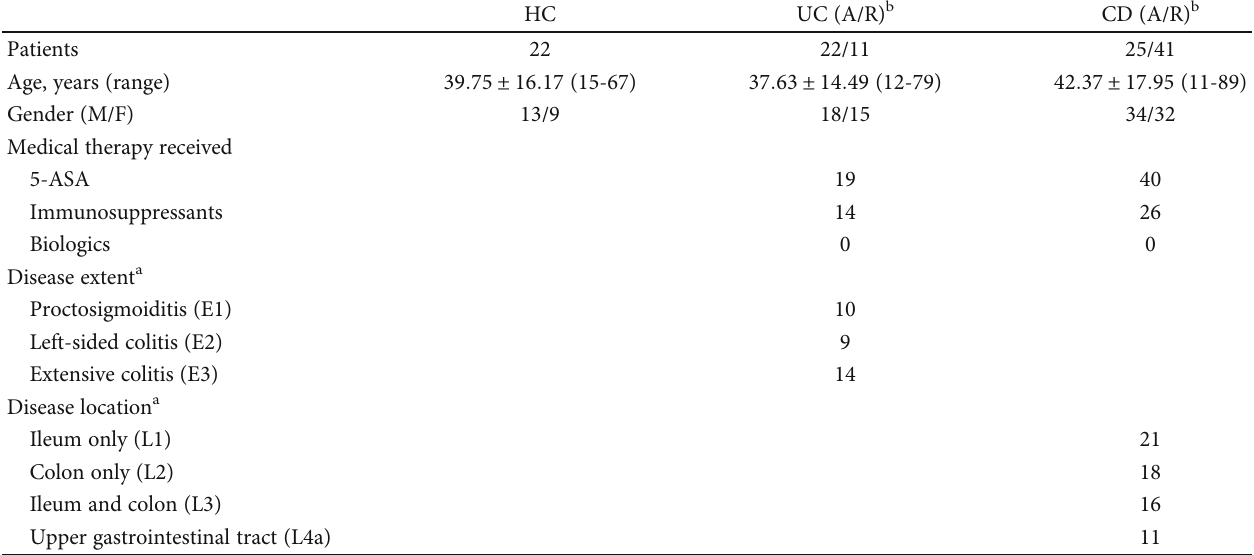
Table 1: The clinical characteristics of IBD patients and healthy